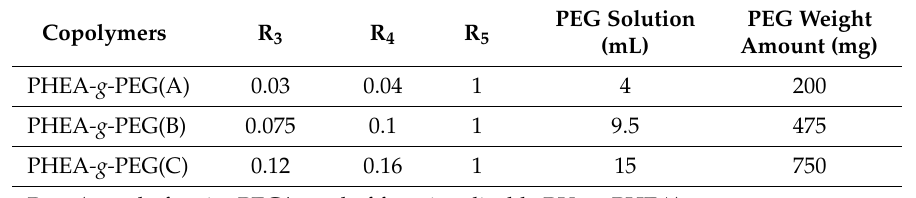
Table 1. Molar ratio and mL of poly(ethyleneglycole) (PEG) solution (50 mg / mL) used for synthesis. Copolymers R 3